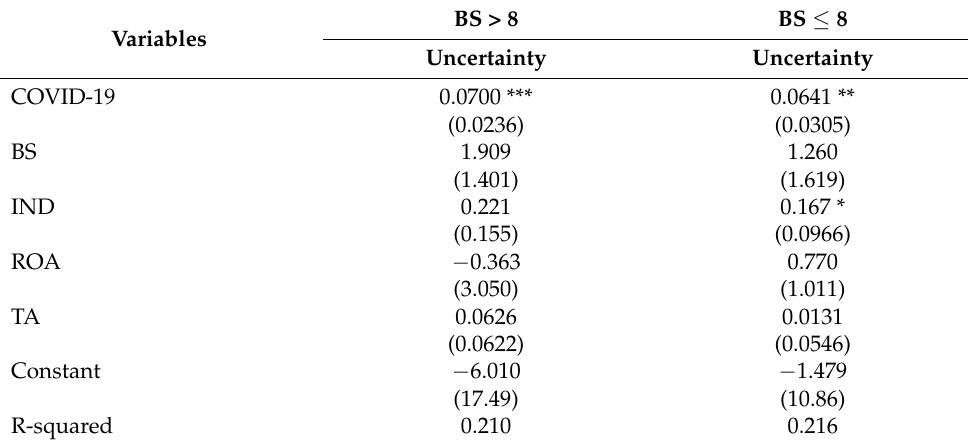
Table 5. Regression for BS > the mean vs. BS ≤ the mean.